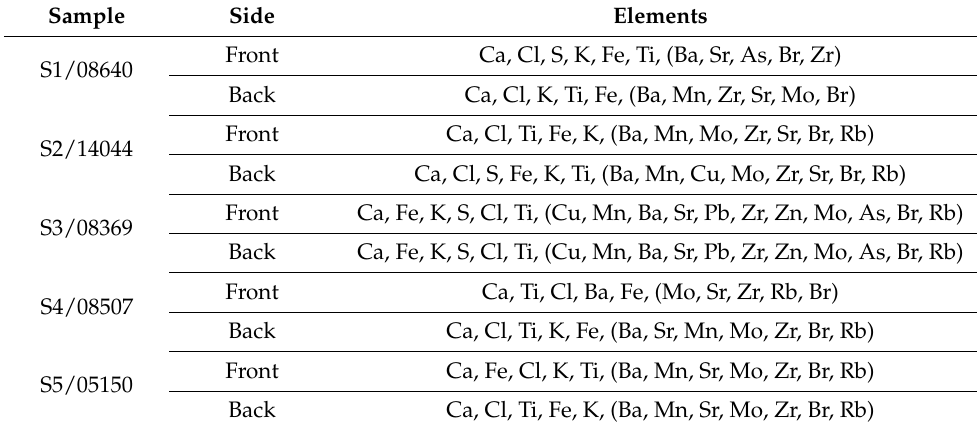
Table 2. List of elements detected using XRF in the investigated samples, in order of abundance. Minor and trace elements are reported in